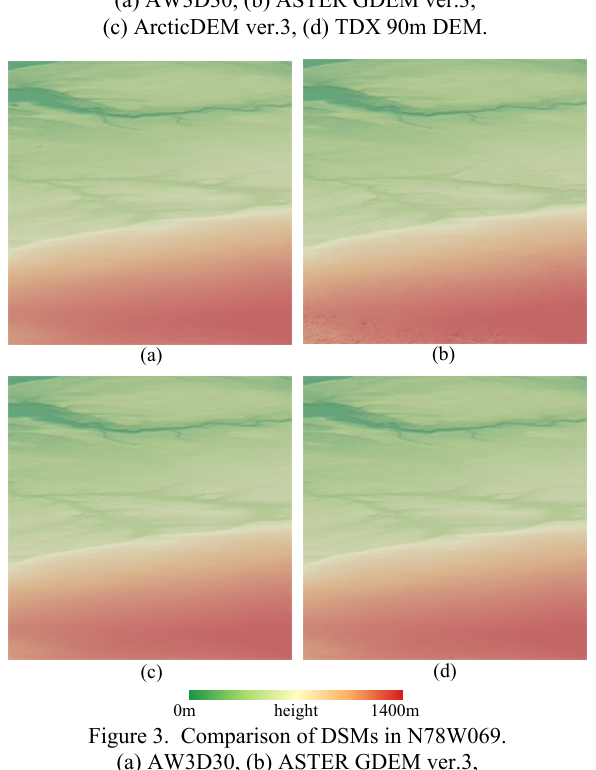
Figure 3. Comparison of DSMs in N78W069. (a) AW3D30, (b) ASTER GDEM ver.3, (c) ArcticDEM ver.3, (d) TDX 90m DEM.